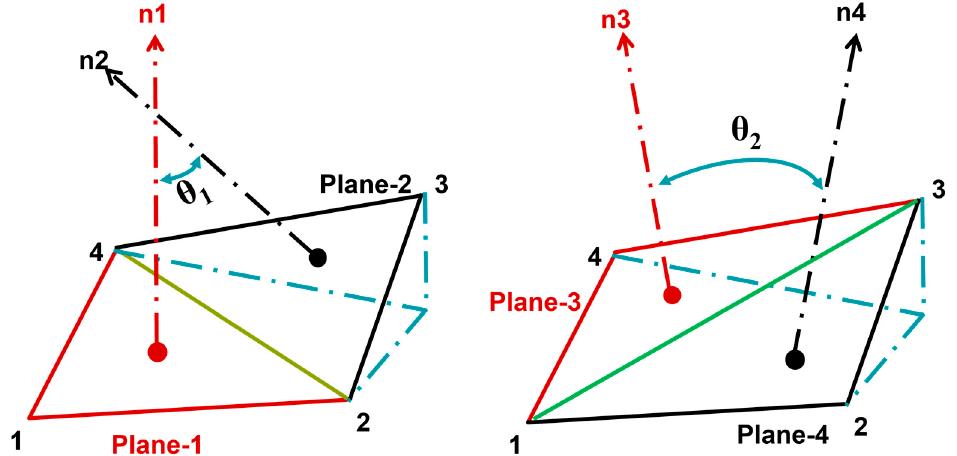
Figure 1. Schematic diagram of warpage angle. Panel-1 consists of nodes 1, 2, 4. Panel-2 consists of nodes 2, 3, 4. Panel-3 consists of nodes 1, 3, 4. Panel-4 consists of nodes 1, 2, 3. n1, n2, n3, n4 are the normals of the faces of Panel-1, Panel-2, Panel-3, and Panel-4, respectively. θ 1 is the angle between n1 and n2. θ 2 is the angle between n3 and n4. The largest angle of the two is taken to be the warpage angle.